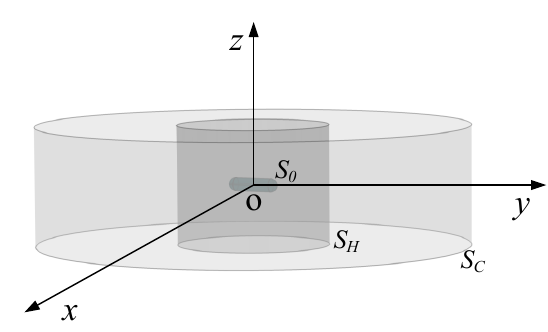
Figure 11. The spatial position relationship between the cylindrical shell with spherical end-caps, the measuring surface, and the calculation surface. S 0 is the surface of the cylindrical shell, S H is the measuring surface, and S C is the calculation